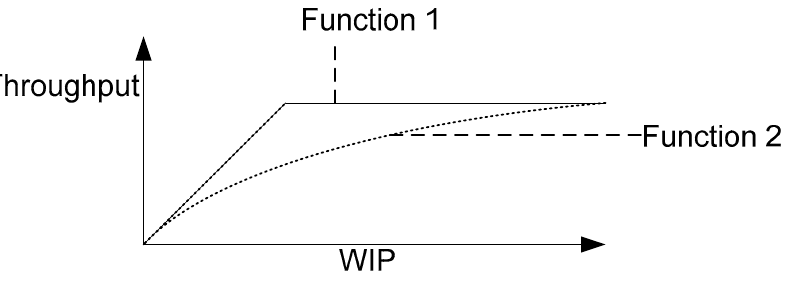
Figure 4. Clearing function representation. WIP––work in progress.